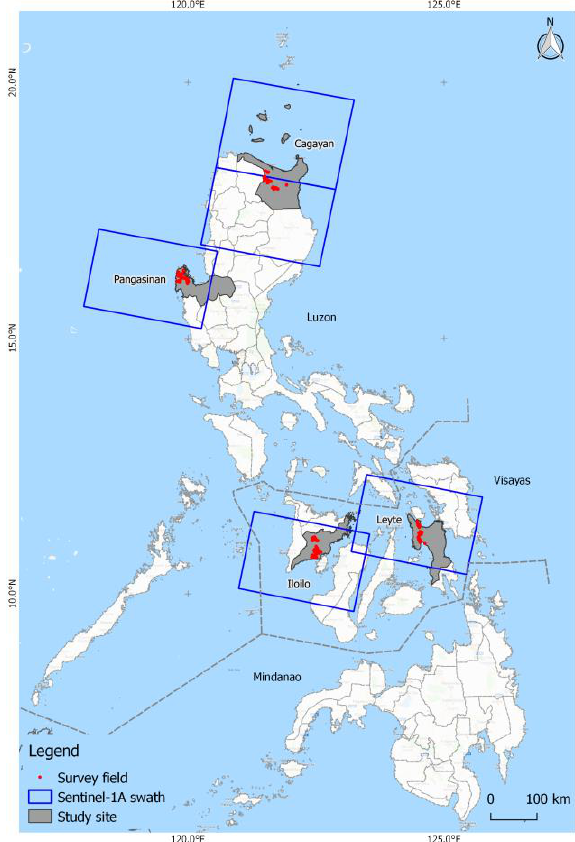
Figure 1. Map showing the location of the surveyed sites and the Sentinel-1A swaths covering the study area.